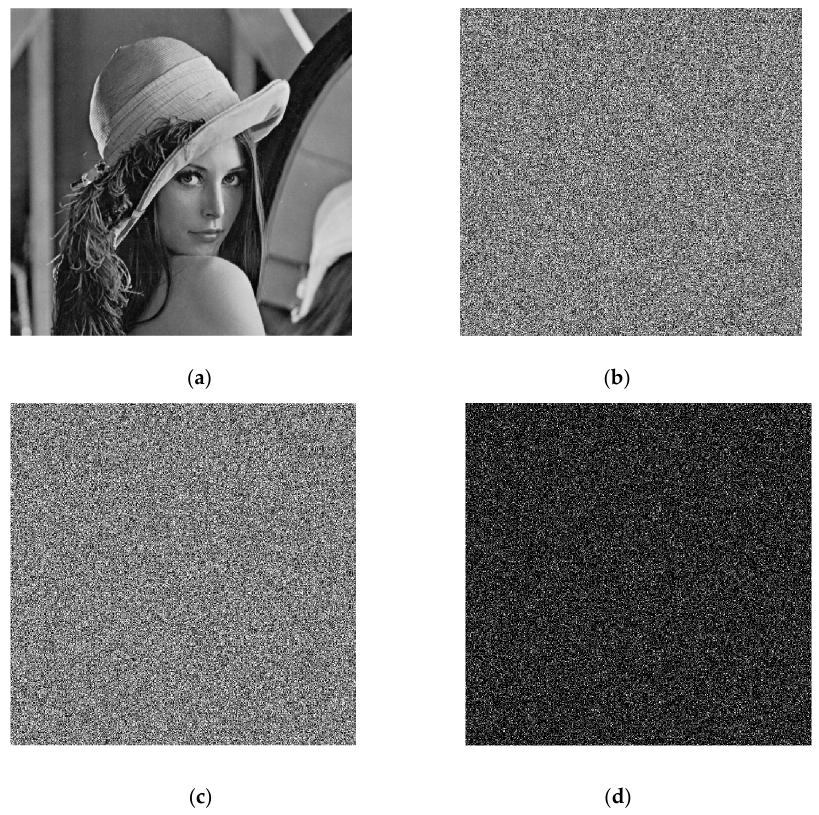
Figure 19. Key sensitivity analysis: ( a ) the original image; ( b ) the encrypted image; ( c ) the recovered image with very slight change (10 − 16 in the fractional order only) in decryption keys; ( d ) the difference between ( a , c ).